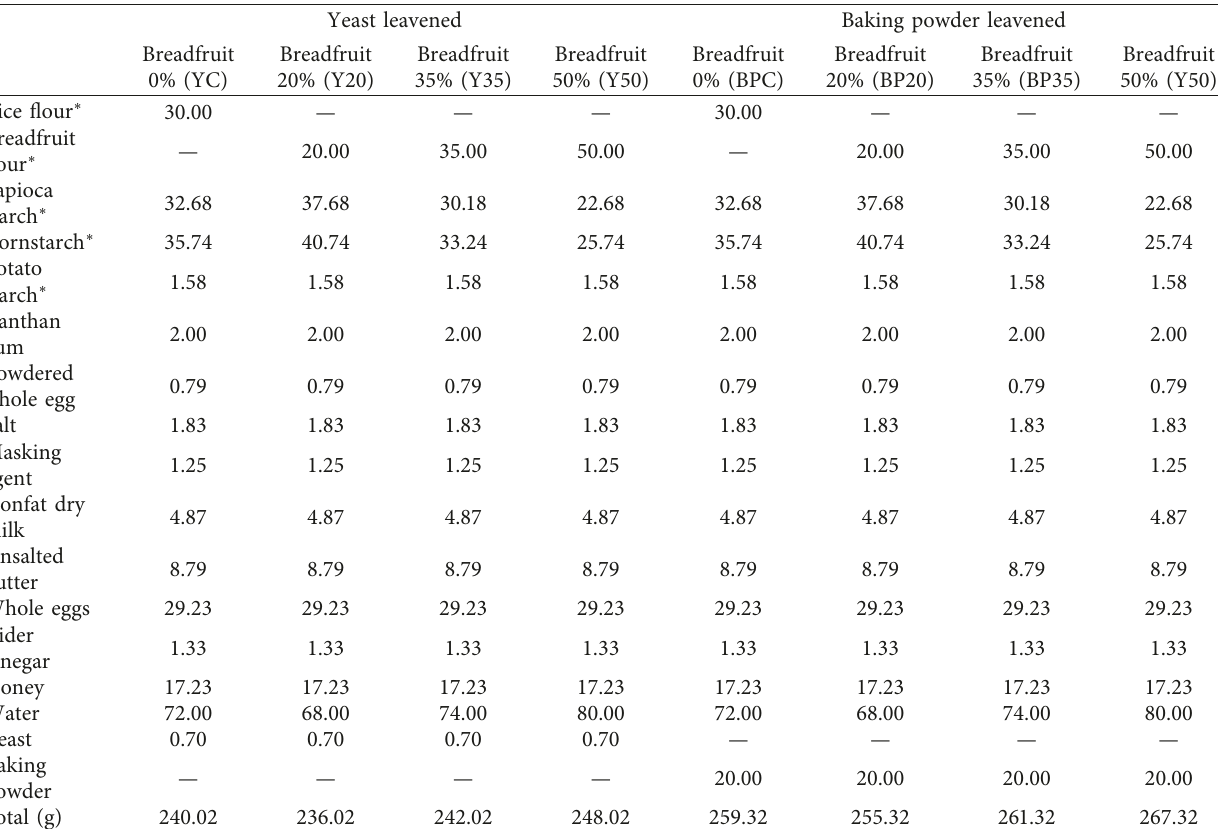
Table 2: Formulations for experimental gluten-free bread made with breadfruit